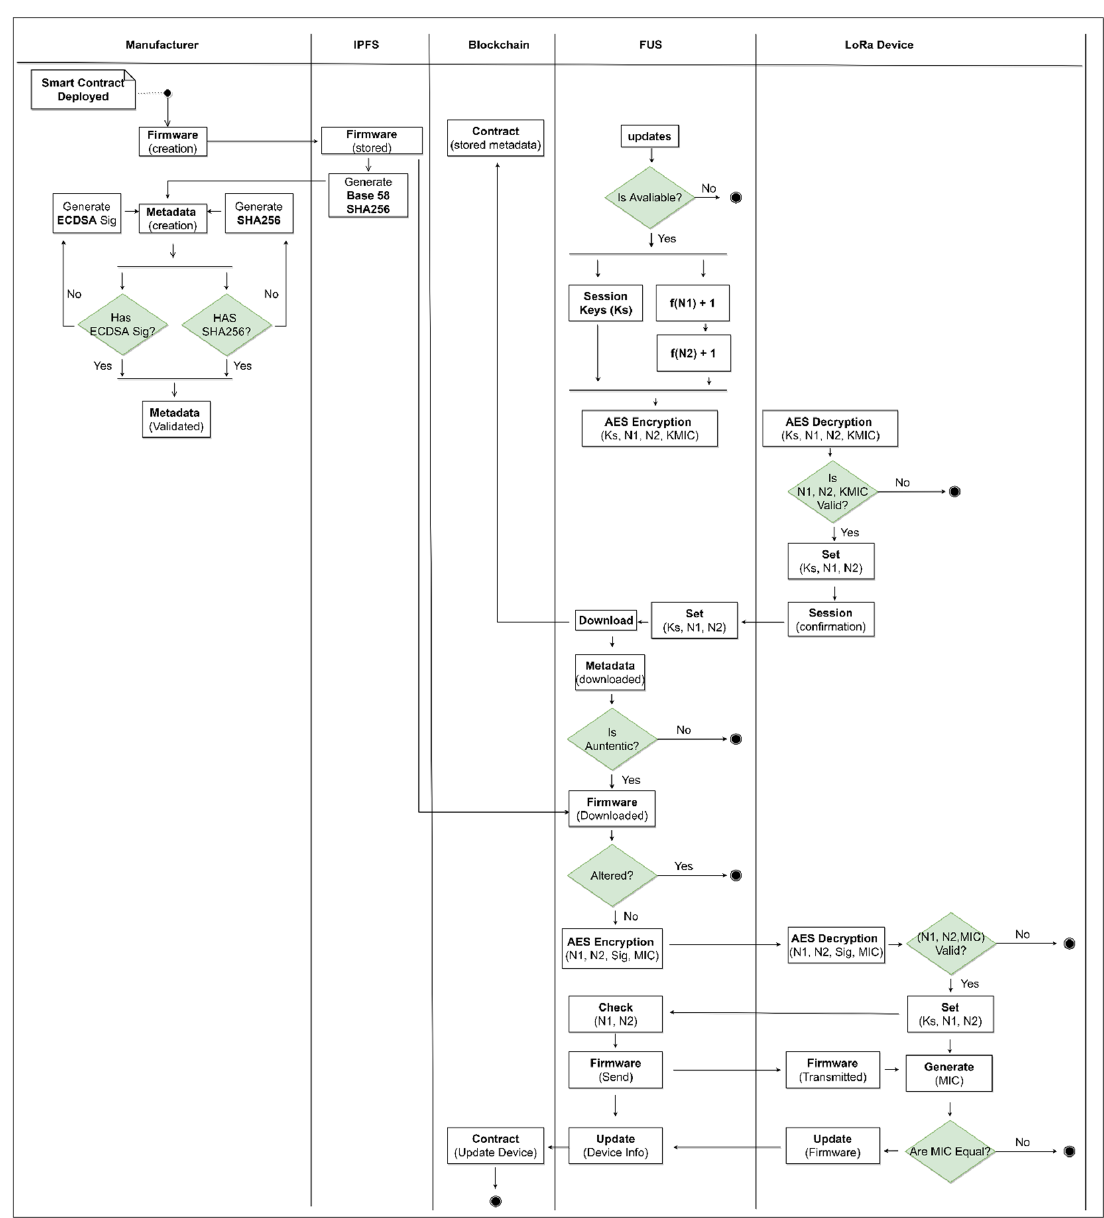
Figure 10. Security Activity